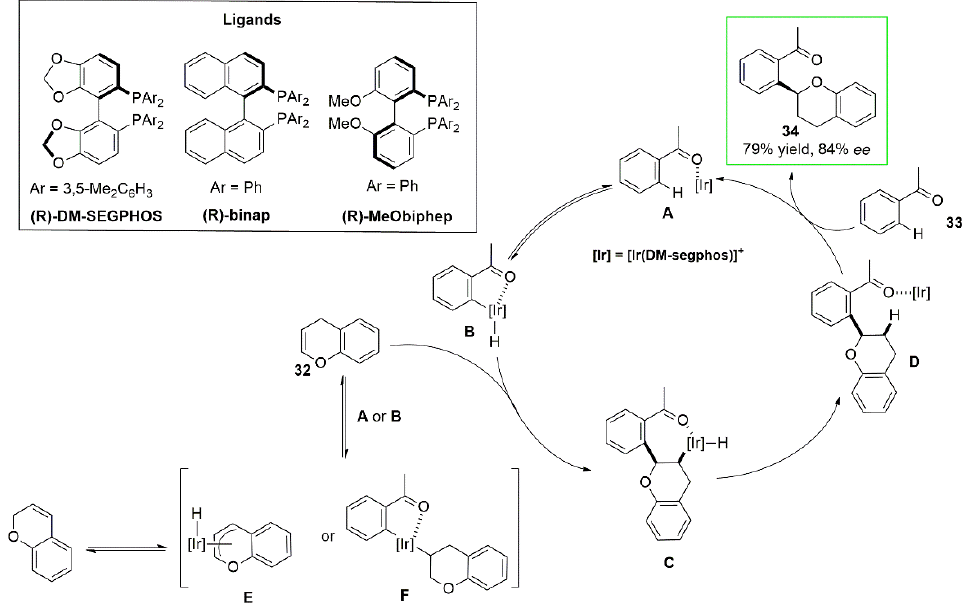
Figure 19. Catalytic cycle of synthesis of 2-arylchromane ( 34 ) via olefin isomerization followed by asymmetric hydroarylation.